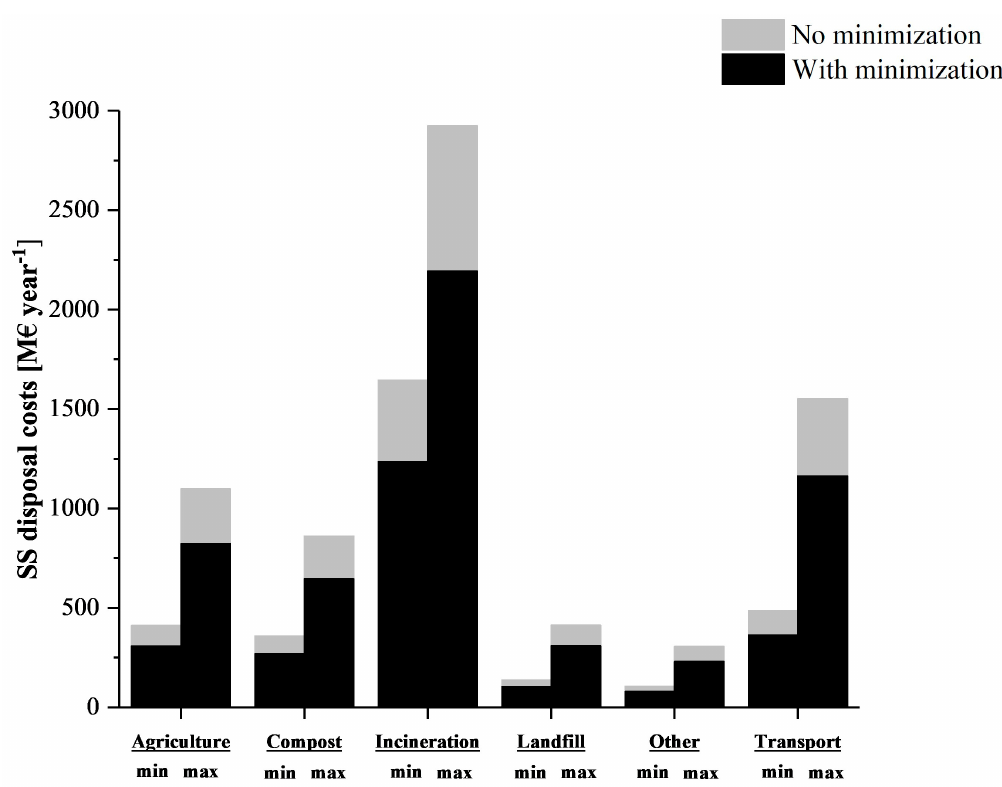
Figure 5. Comparison between the total costs of the different SS disposal options in Europe in 2015, before and after the hypothetical application of minimization techniques in the plants with more than 100,000 PE. A range of SS disposal costs, between a minimum and maximum value, was determined considering the high variability within the different EU countries.